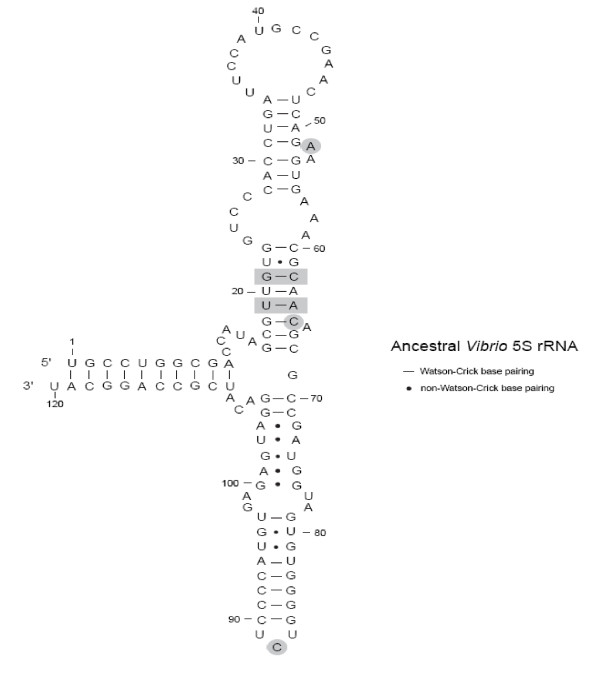
Ancestral Vibrio 5S rRNA Sequence. The secondary structure is shown in an orientation that resembles that seen in the 50S subunit crystal structure. The seven highlighted bases indicate locations where the ancestral sequence (node 1) differs from the wild type V. proteolyticus sequence. Position numbering is the same for E. coli and V. proteolyticus.